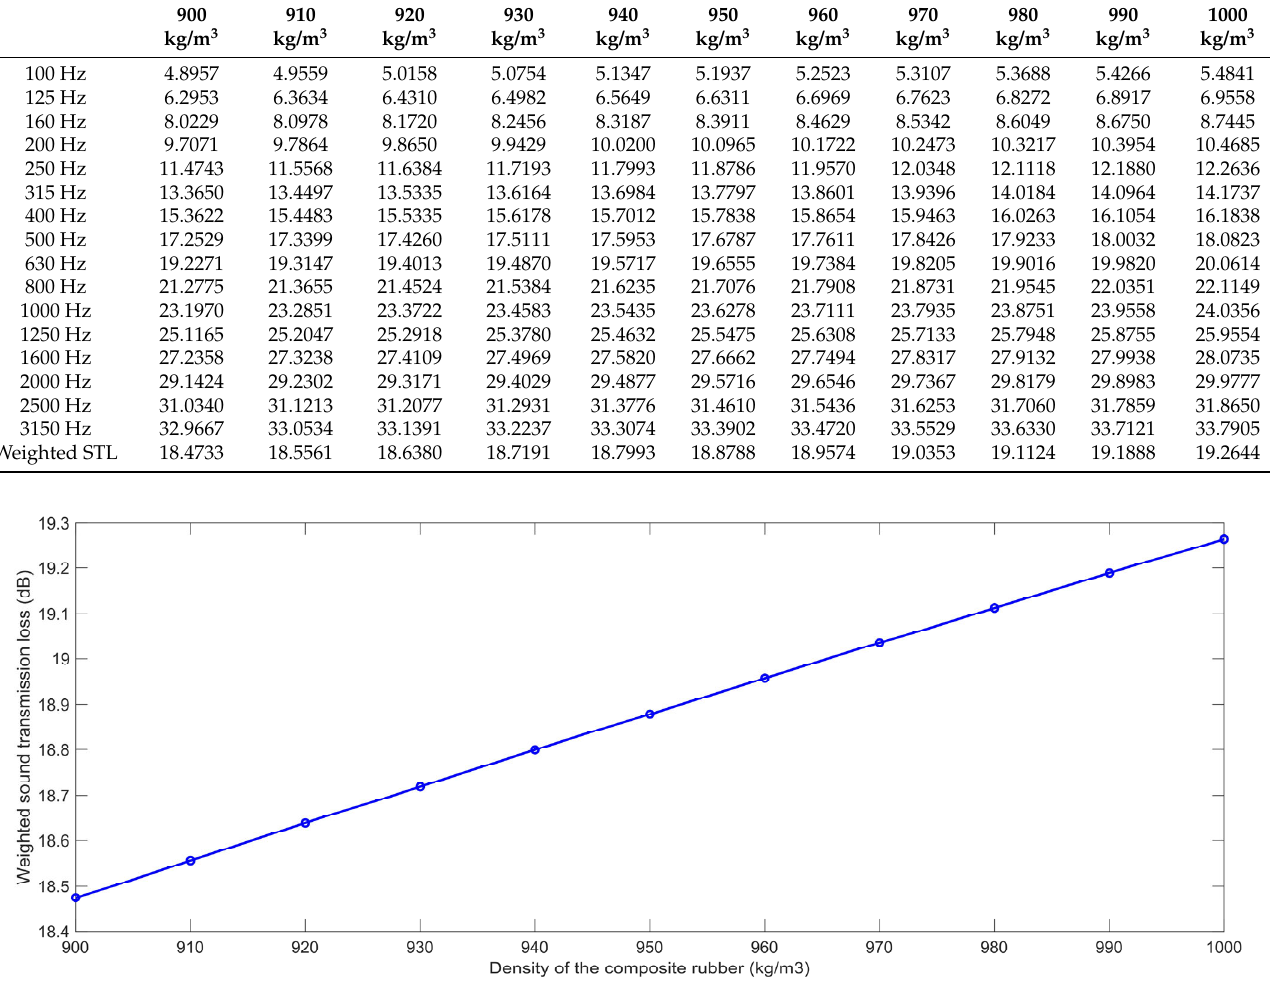
Figure 14. The weighted STL of composite rubber reinforced with HGM for the various density of the composite rubber.